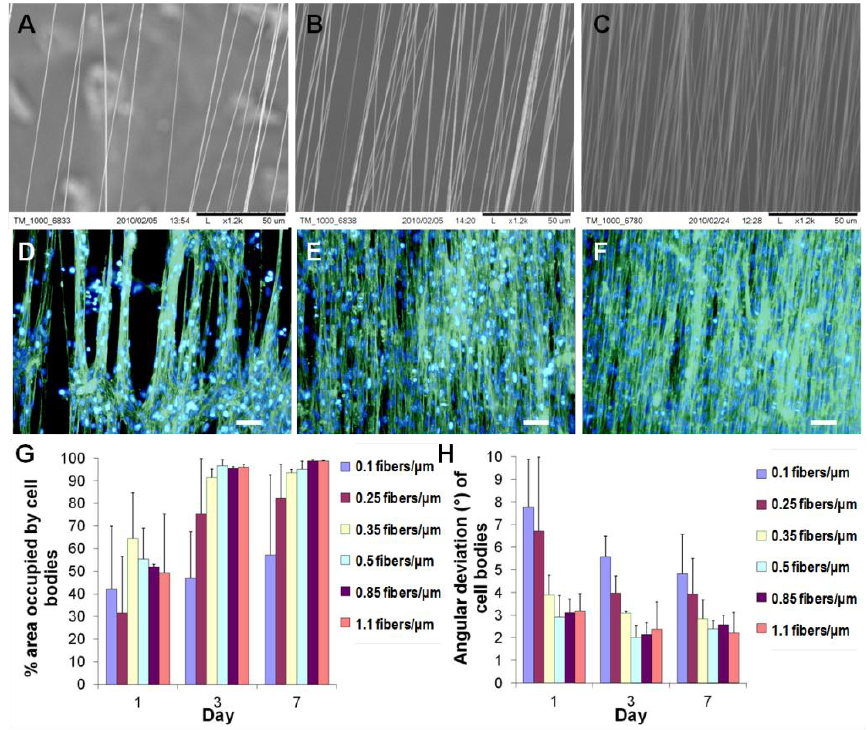
Figure 3. ( Top ) Representative SEM images of aligned PCL nanofiber sheets of three different fiber densities of ( A ) 0.1 fibers/µm, ( B ) 0.35 fibers/µm, and ( C ) 0.85 fibers/µm. ( Middle ) C2C12 cells at seven days in culture on the nanofiber sheets of different fiber densities corresponding to those in the top panel. Actin filaments were stained in green, and cell nuclei were stained in blue. Scale bar = 50 μm. ( Bottom ) Quantitative measurements of the percent of cell confluence ( G ) and cell alignment ( H ) of C2C12 cells cultured on aligned nanofiber sheets of fiber densities in the range of 0.1–1.1